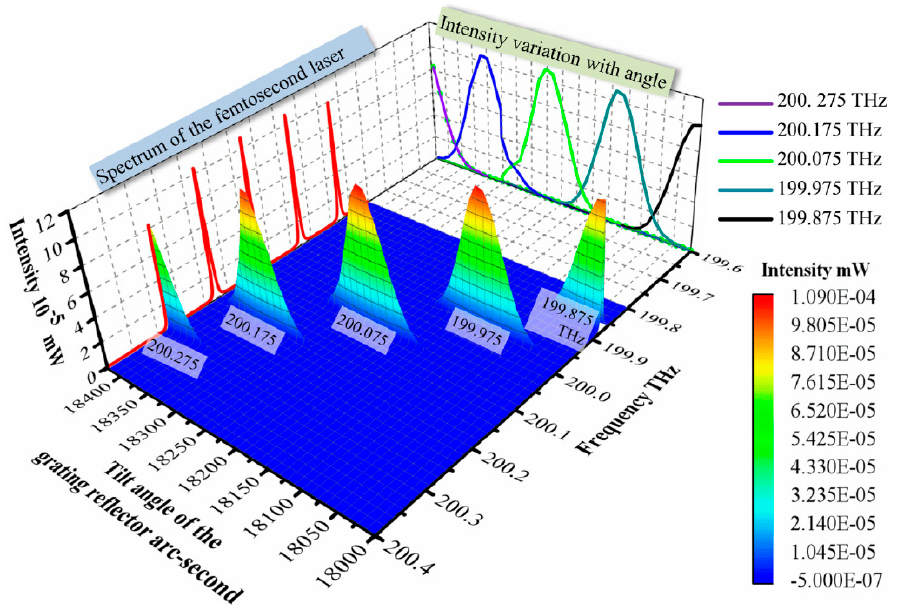
Figure 8. Reading output of the mode-locked femtosecond laser autocollimator with a visibility of 100% observed in the optical frequency domain [56].